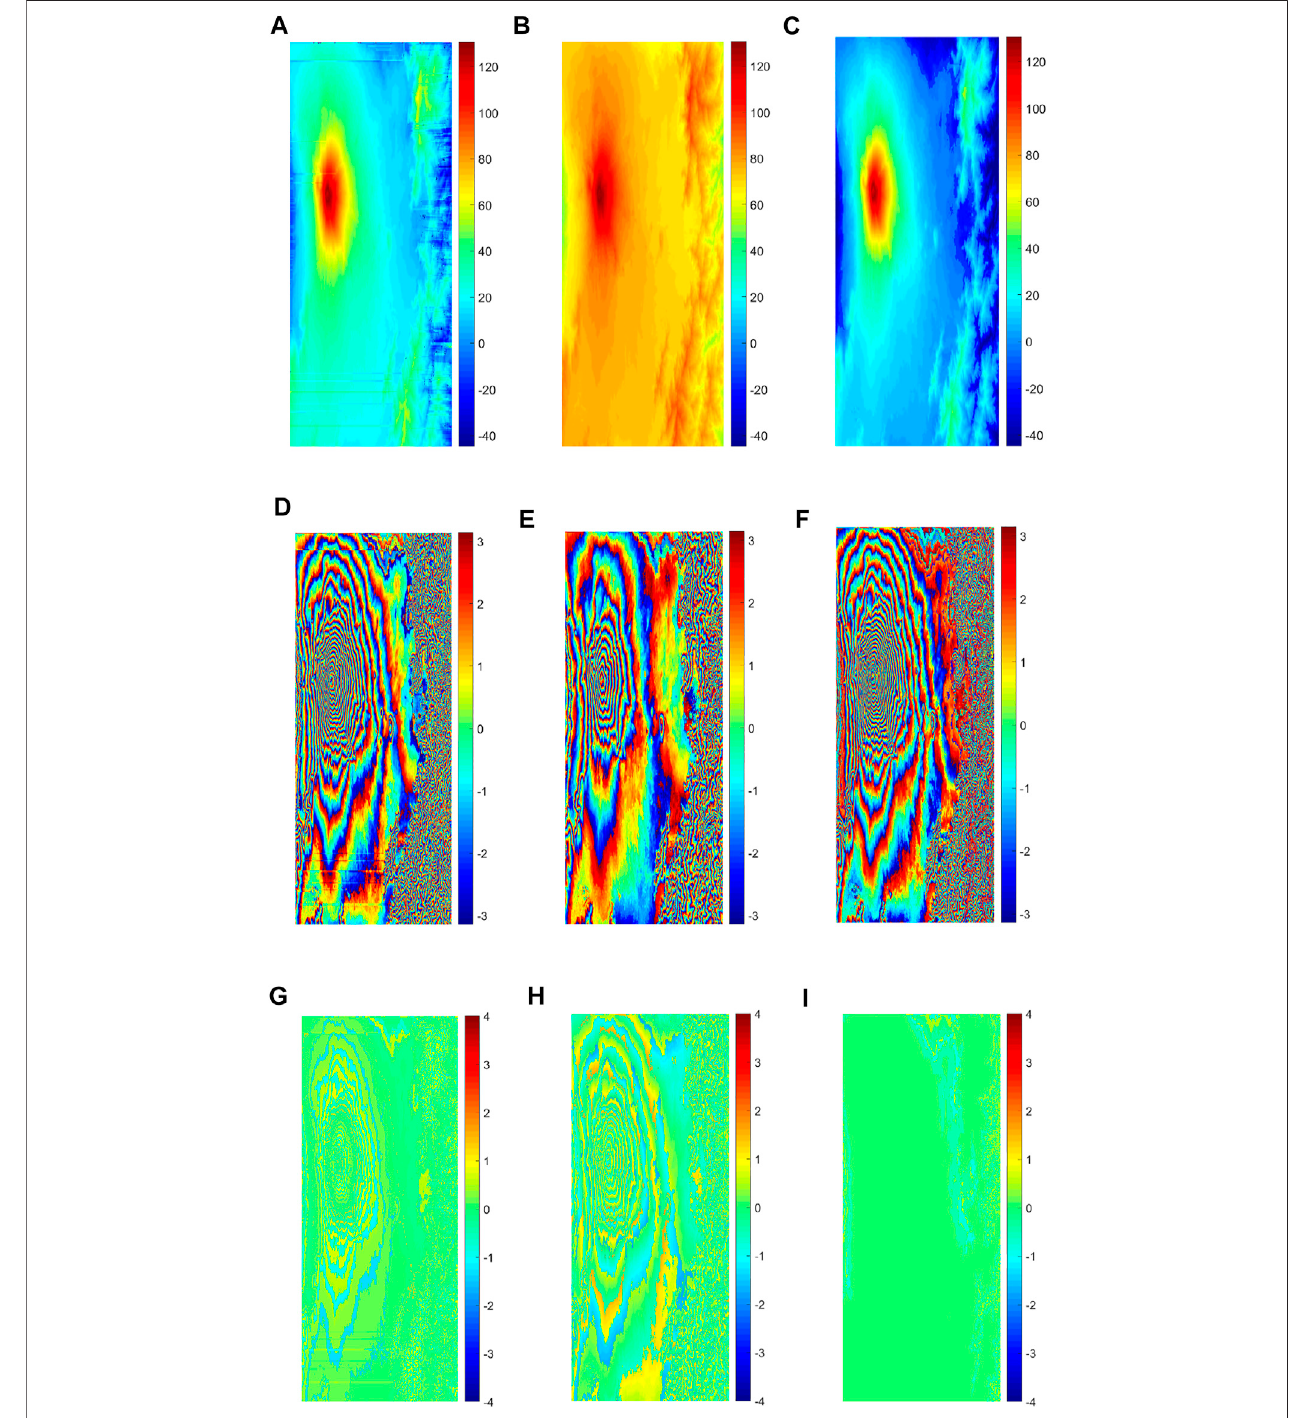
FIGURE 18 | Unwrapping results of real data. (A) Branch-cut method (rad). (B) LS method (rad). (C) MFC method (rad). (D) Re-wrapped results of the branch-cut method(rad). (E) Re-wrappedresultsoftheLSmethod(rad). (F) Re-wrappedresultsoftheMFCmethod(rad). (G) Phaseerrorsbetweenre-wrappedresultsandoriginal interferogram of the branch-cut method (rad). (H) Phase errors between re-wrapped results and original interferogram of the LS method (rad). (I) Phase errors between re-wrapped results and original interferogram of the MFC method (rad).